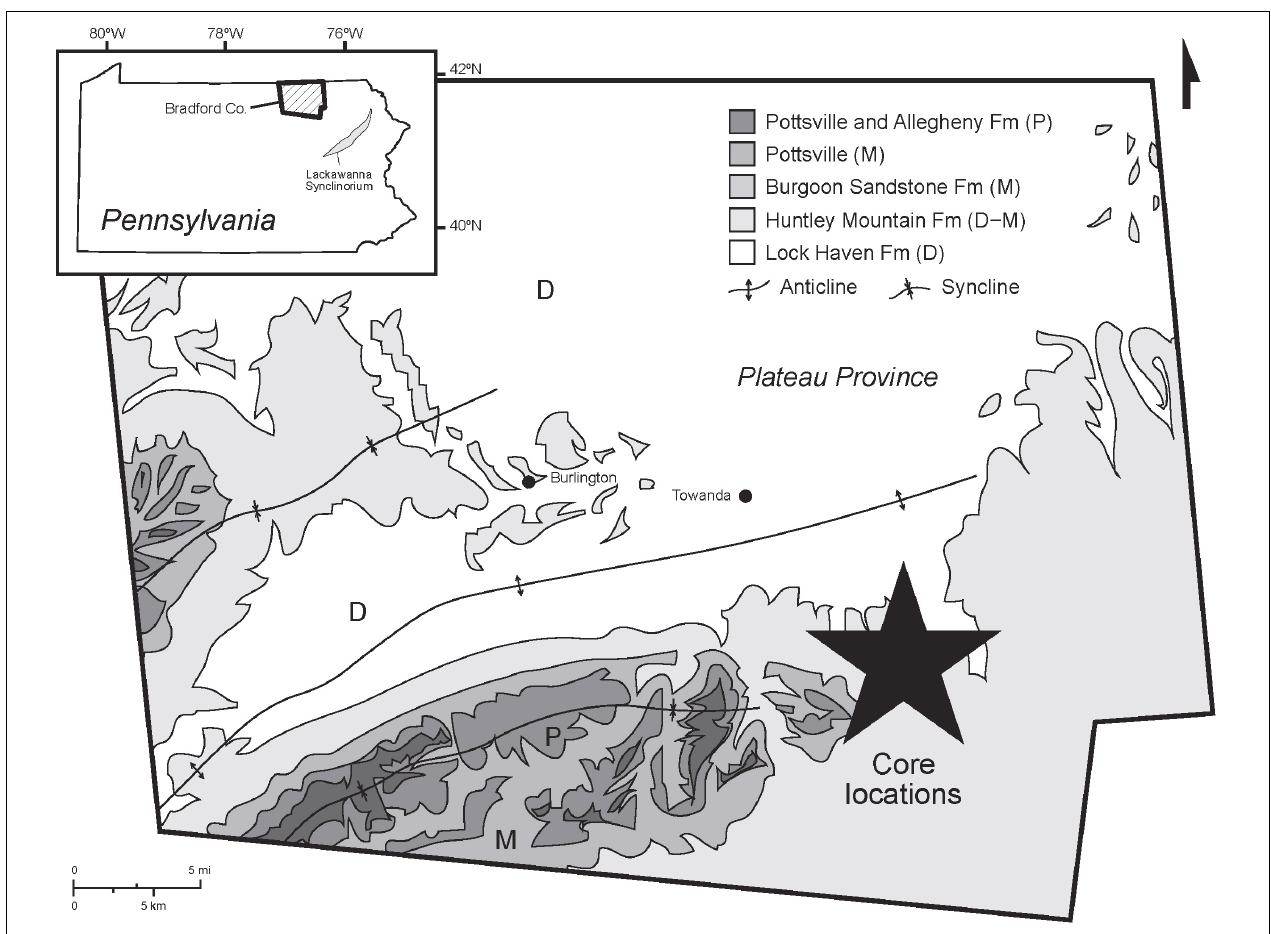
FIGURE 1 | Geologic map showing the study area in Bradford County, PA. The star indicates core locations (Modified from Berg et al., 1980).